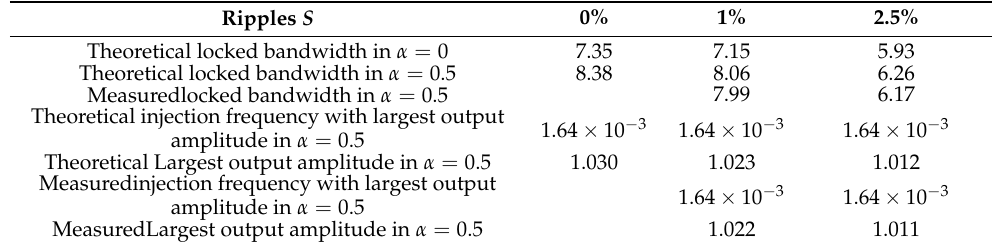
Table 5. Theoretical and experimental bandwidth locking under different ripple and pushing effect. Ripples S